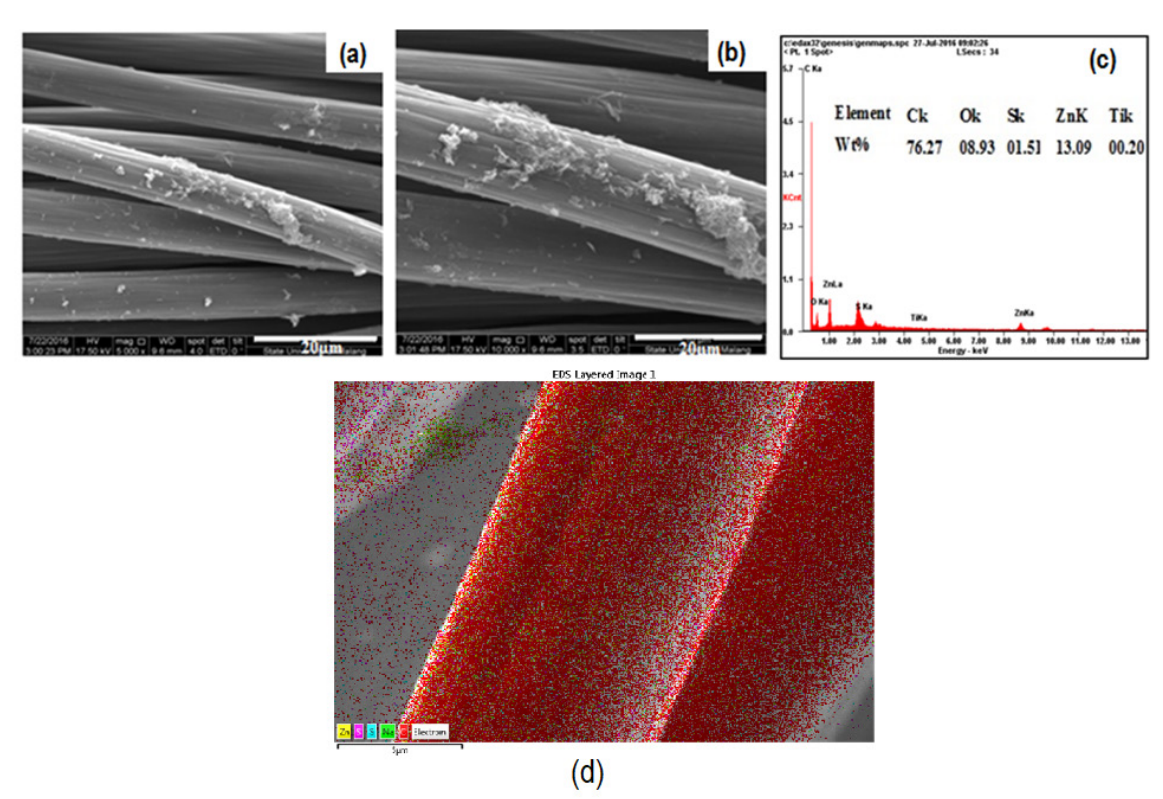
/C-fiber at different magnification (a), (b), its EDX analysis (c), and its elemental mapping (d). Figure 6: SEM images of ZnS-TiO 2 Tabel 1: The gap energy values of the prepared materials.